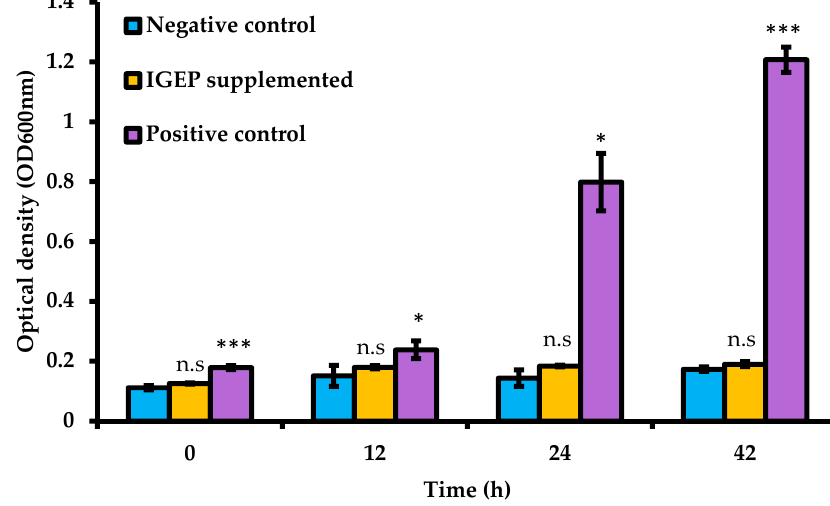
Figure 4. Growth of B. infantis in carbohydrate-free media supplemented with IGEP over 48 h (IGEP-supplemented) compared to a positive control of culture in de Man–Rogosa–Sharpe (MRS) with glucose and a negative control of non-supplemented carbohydrate-free media. Optical density at 600 nm was measured at 0, 6, 12, 24, and 48 h post-inoculation. Results are represented as the average of three replicates, with error bars representing ± one standard deviation. The Student t -tests were used to test for significance in comparison to the negative control. *, p -value < 0.05; ***, p -value < 0.002; n.s., not significant.